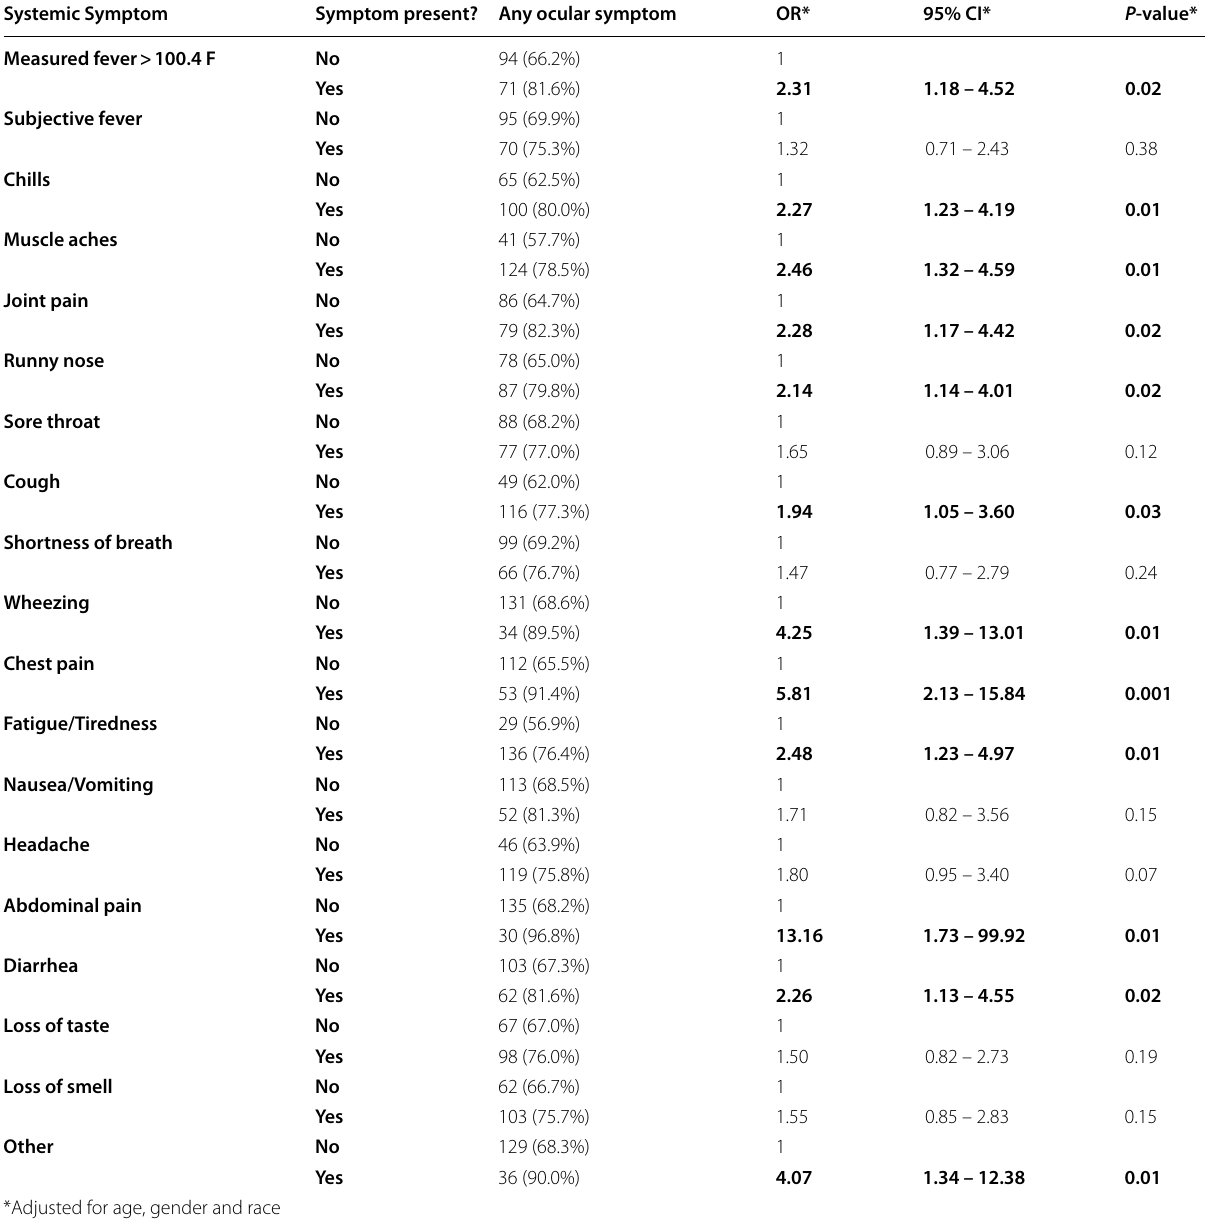
Table 4 Relationship between systemic symptoms and any ocular symptoms adjusted for age, gender, and race. Significant results ( p < 0.05) are displayed in bold text Systemic Symptom Symptom present? Any ocular symptom OR* 95% CI* P -value* Measured fever > 100.4